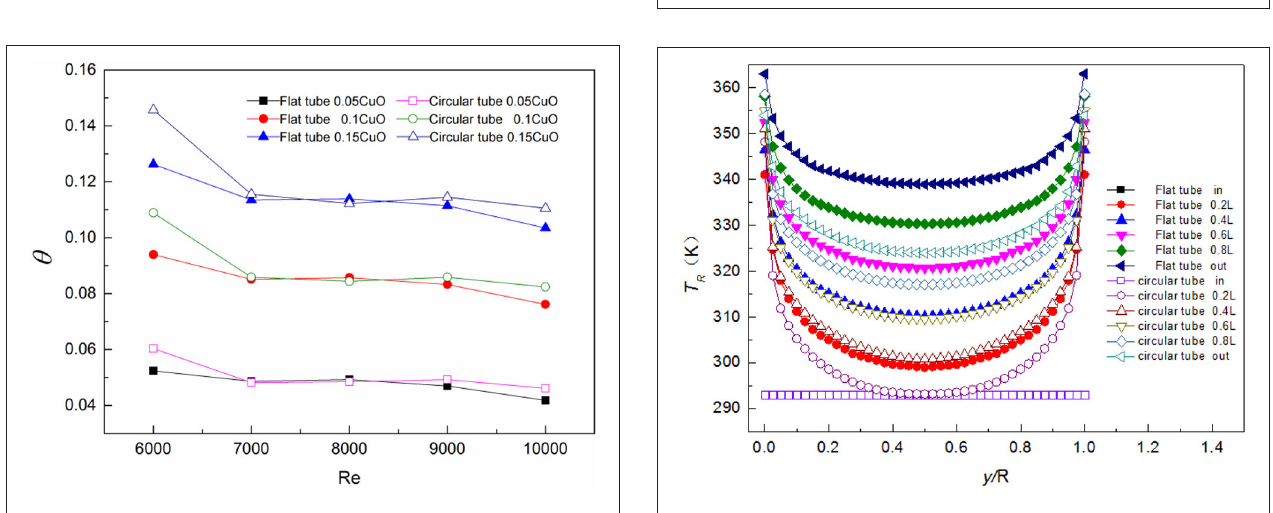
FIGURE 7 | Change of heat transfer coefficient increase with Reynolds number.